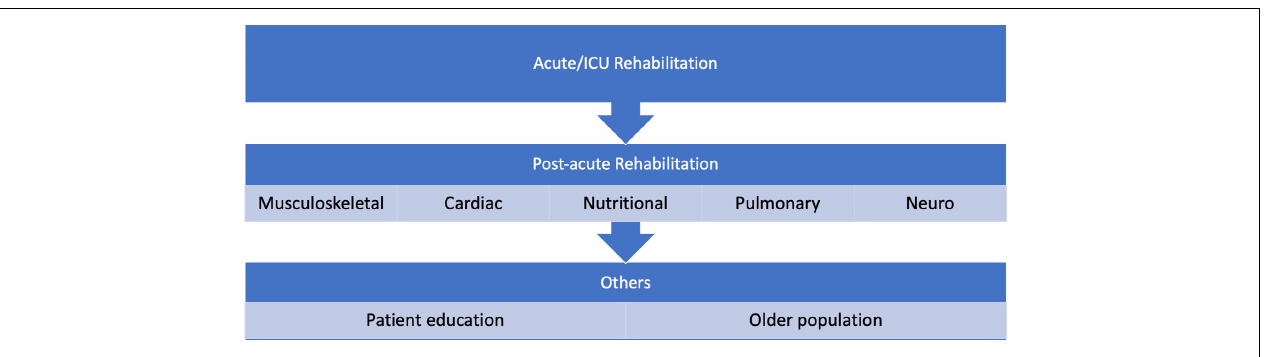
FIGURE 3 | Structure of patient journey